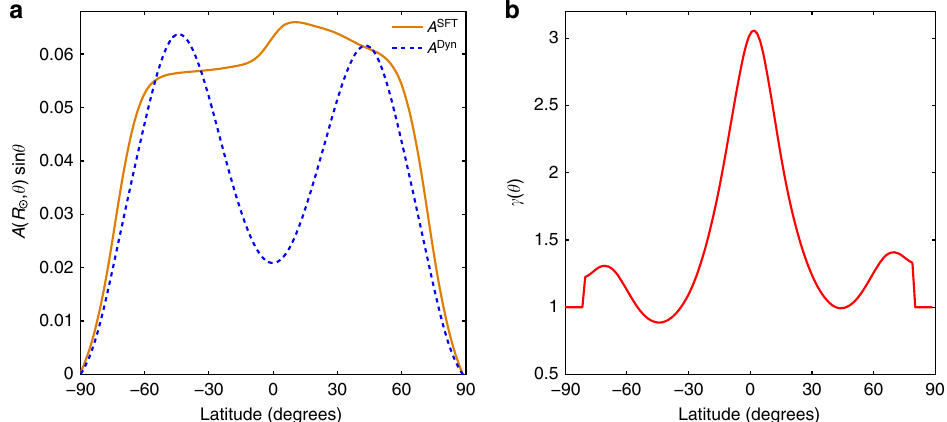
Fig. 5 Vector potential on the solar surface obtained from solar surface fl ux transport and dynamo simulations at the beginning of cycle 17. a Depicts a comparison between A SFT ð R (cid:2) ; θ Þ sin θ and A Dyn ð R (cid:2) ; θ Þ sin θ . b Depicts the associated γ ( θ